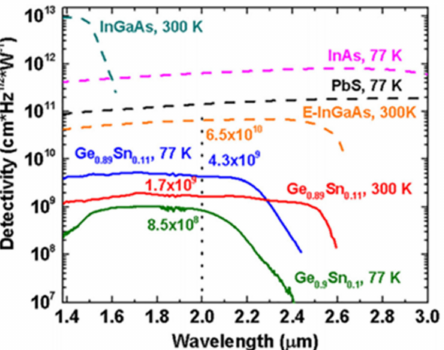
Figure 22. Specific detectivity for a Ge 0.89 Sn 0.11 photodetector at the temperatures of 77 and 300 K. Reproduced with permission from [65], AIP Publishing, 2018.